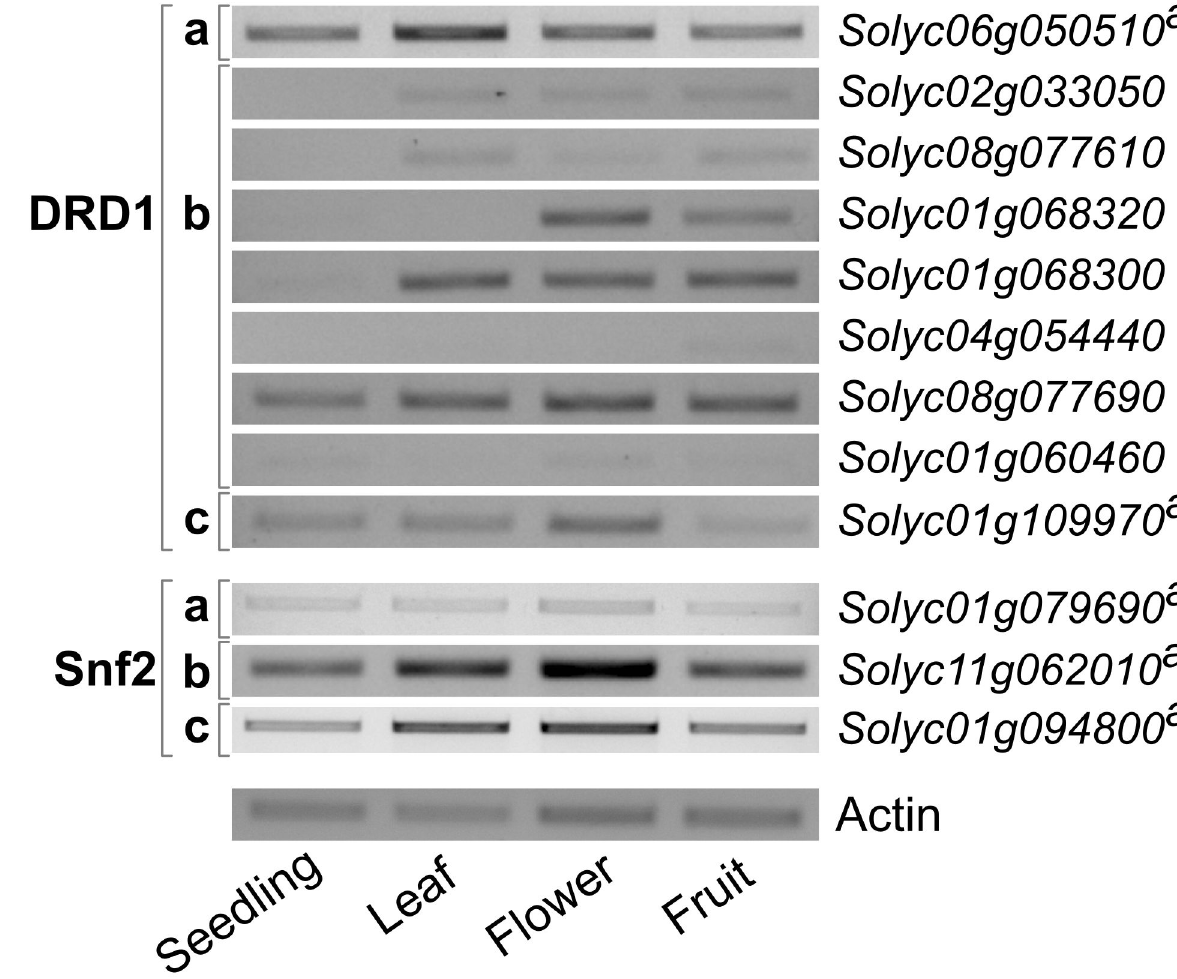
Figure 4. RT-PCR expression analysis of DRD1 and Snf2 subfamilies of tomato Snf2 ATPase genes. The tissue used is indicated on the x-axis. The individual genes are indicated of the right, the branches identified on the left. The expression of the actin gene (25 cycles) was used as control (lower panel). The number of PCR cycles used for the analysis of the individual gene was adjusted to generate a detectable amount of PCR product. For most of genes, 35 cycles were used. Genes marked with superscript a ( a ) were amplified with 29 cycles. For the actin gene 25 cycles were